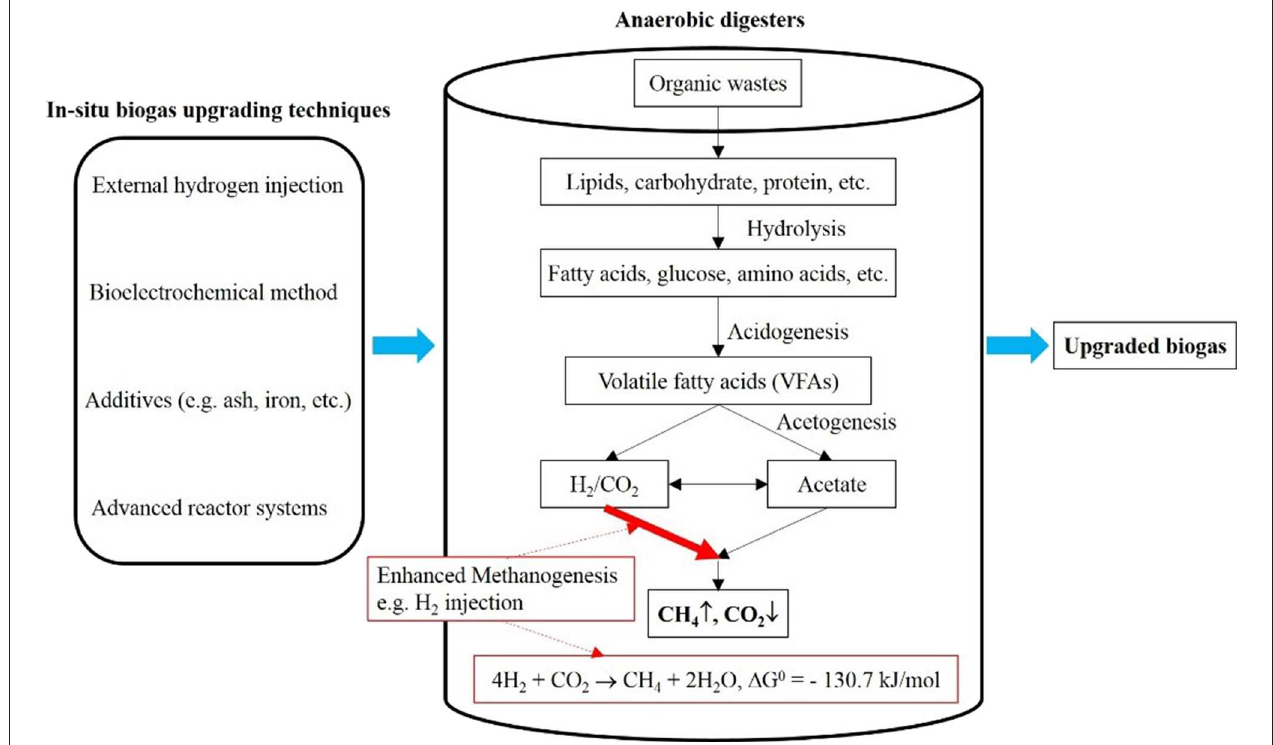
FIGURE 1 | Theoretical basis of enhanced hydrogenotrophic methanogenesis for biogas